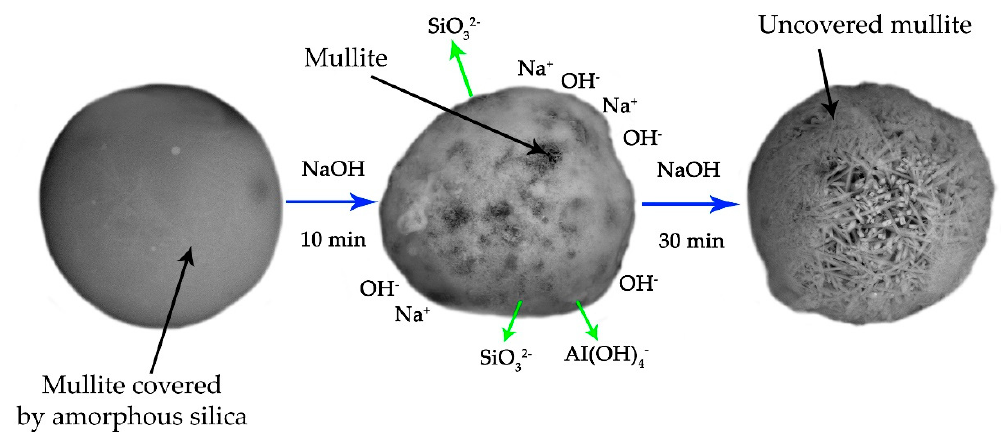
Figure 9. The mechanism of CFA desilication with the formation of acicular mullite particles.